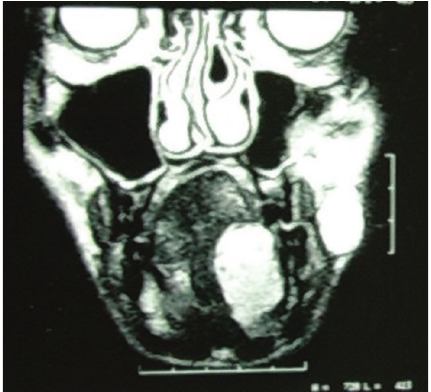
Figure 3: MRI showing hyperintense T2-weighted images with no flow